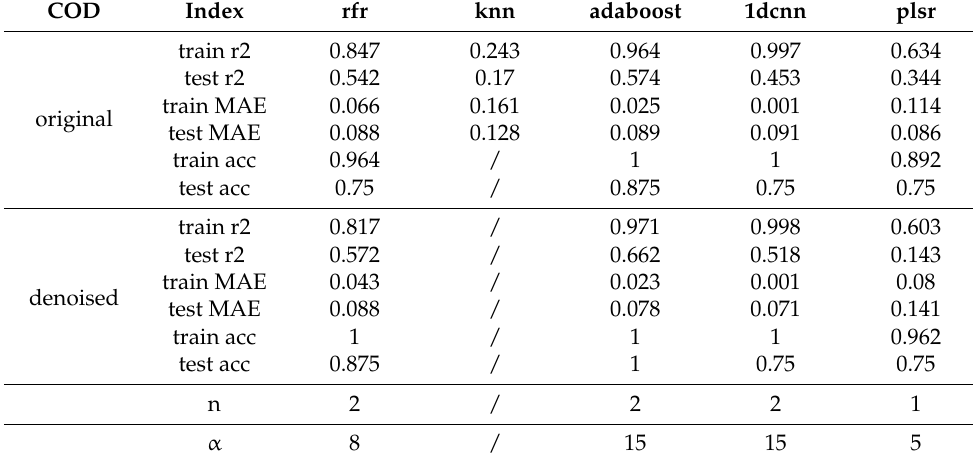
Table 6. The accuracy results of retrieving